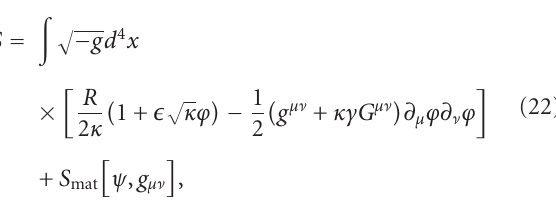
Figure 7: Evolution of the parameters for metric perturbations (scalar and tensorial parts), respectively, Q S , c 2 in the text versus the scale factor, for γ = − 1. This model with γ < 0 is well behaved but does not accommodate